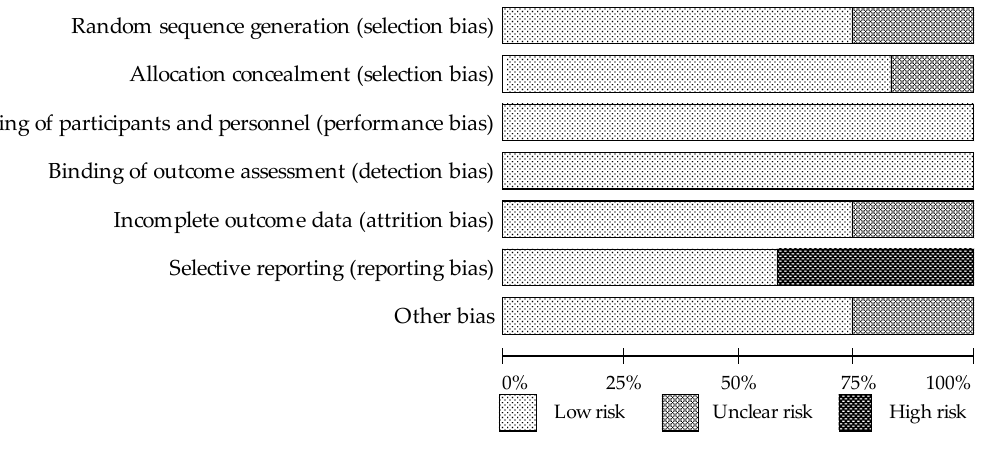
Figure 3 . The assessment of risk of bias for each item; data are shown as a percentage for trials.